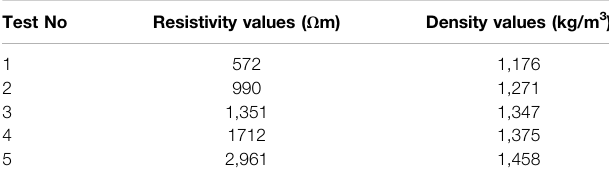
TABLE 5 | Result of calculated density values and model resistivity values at designated location.